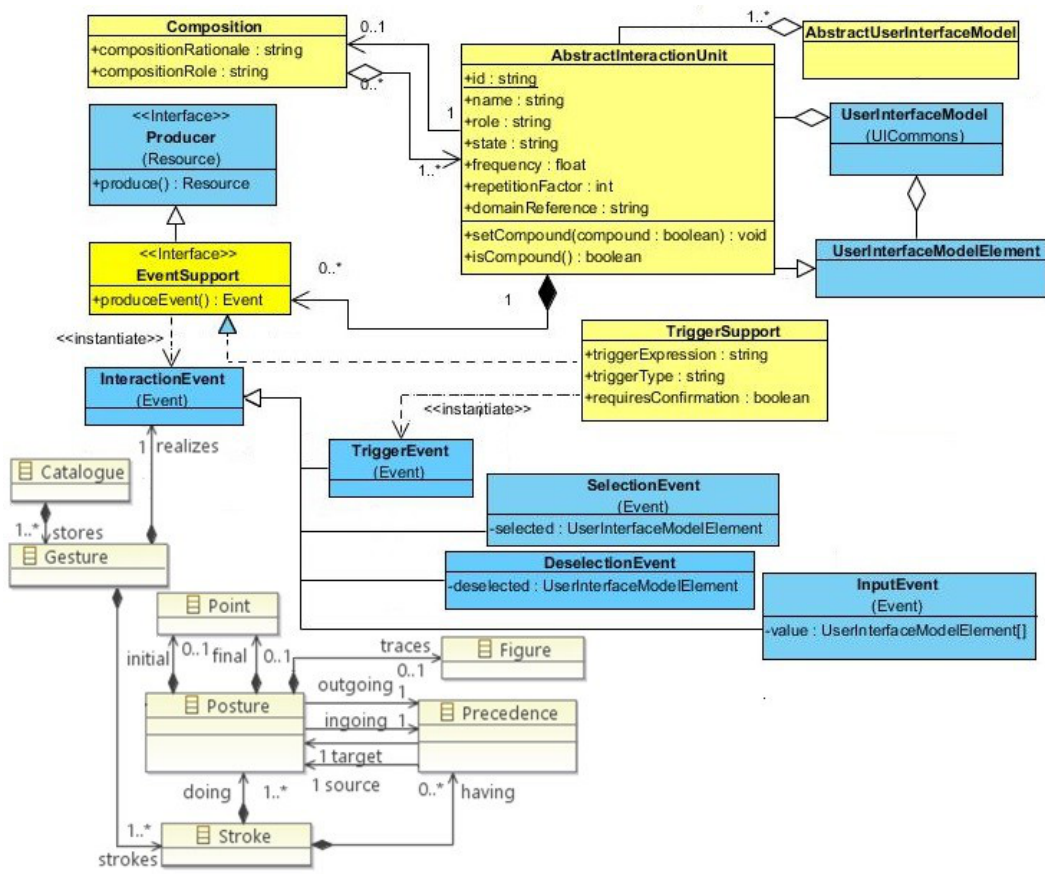
Figure A1.3 . Including gesture catalogue metamodel in MBUID AUI